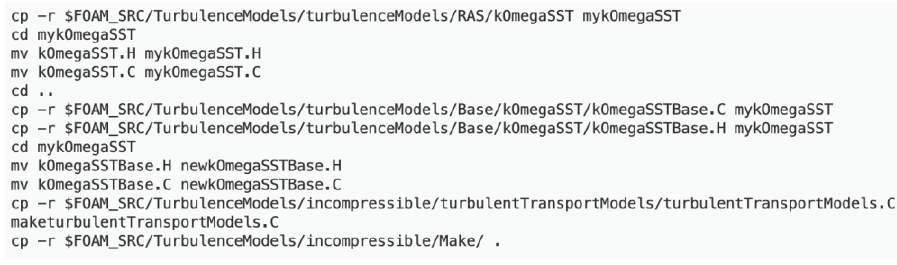
Figure 8. Commands used to copy all necessary files to implement VLES.